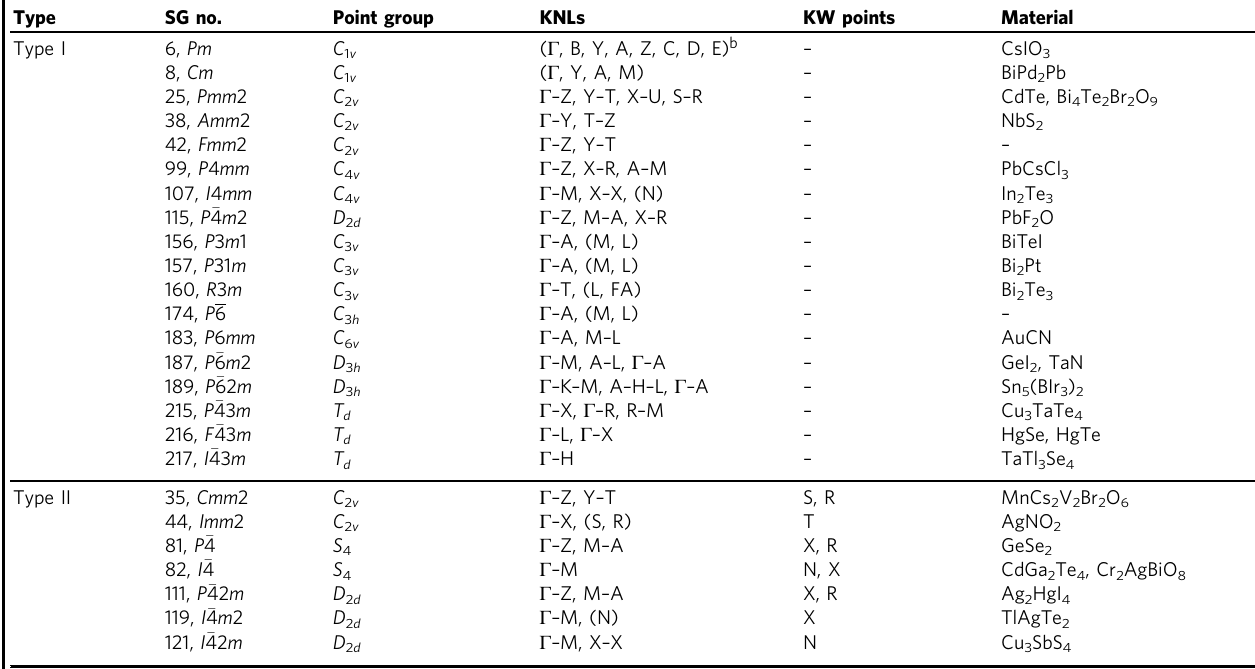
Table 1 Kramers nodal line metals (KNLMs) with symmorphic space groups a .